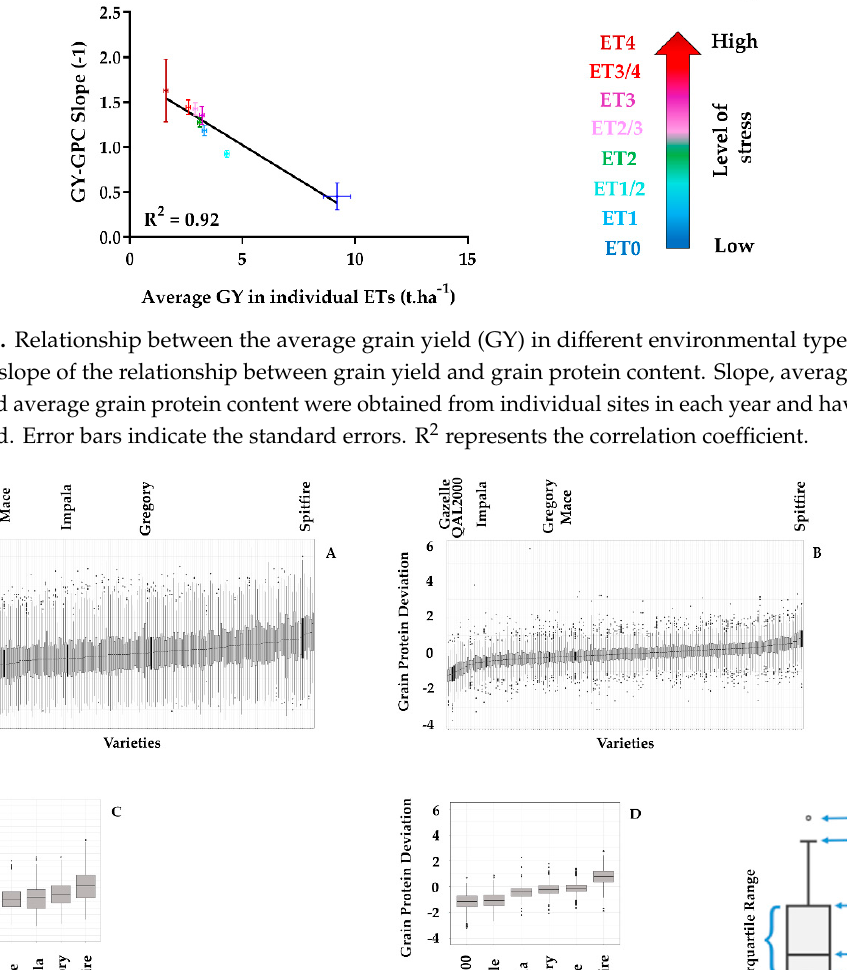
Supplementary Data S2).